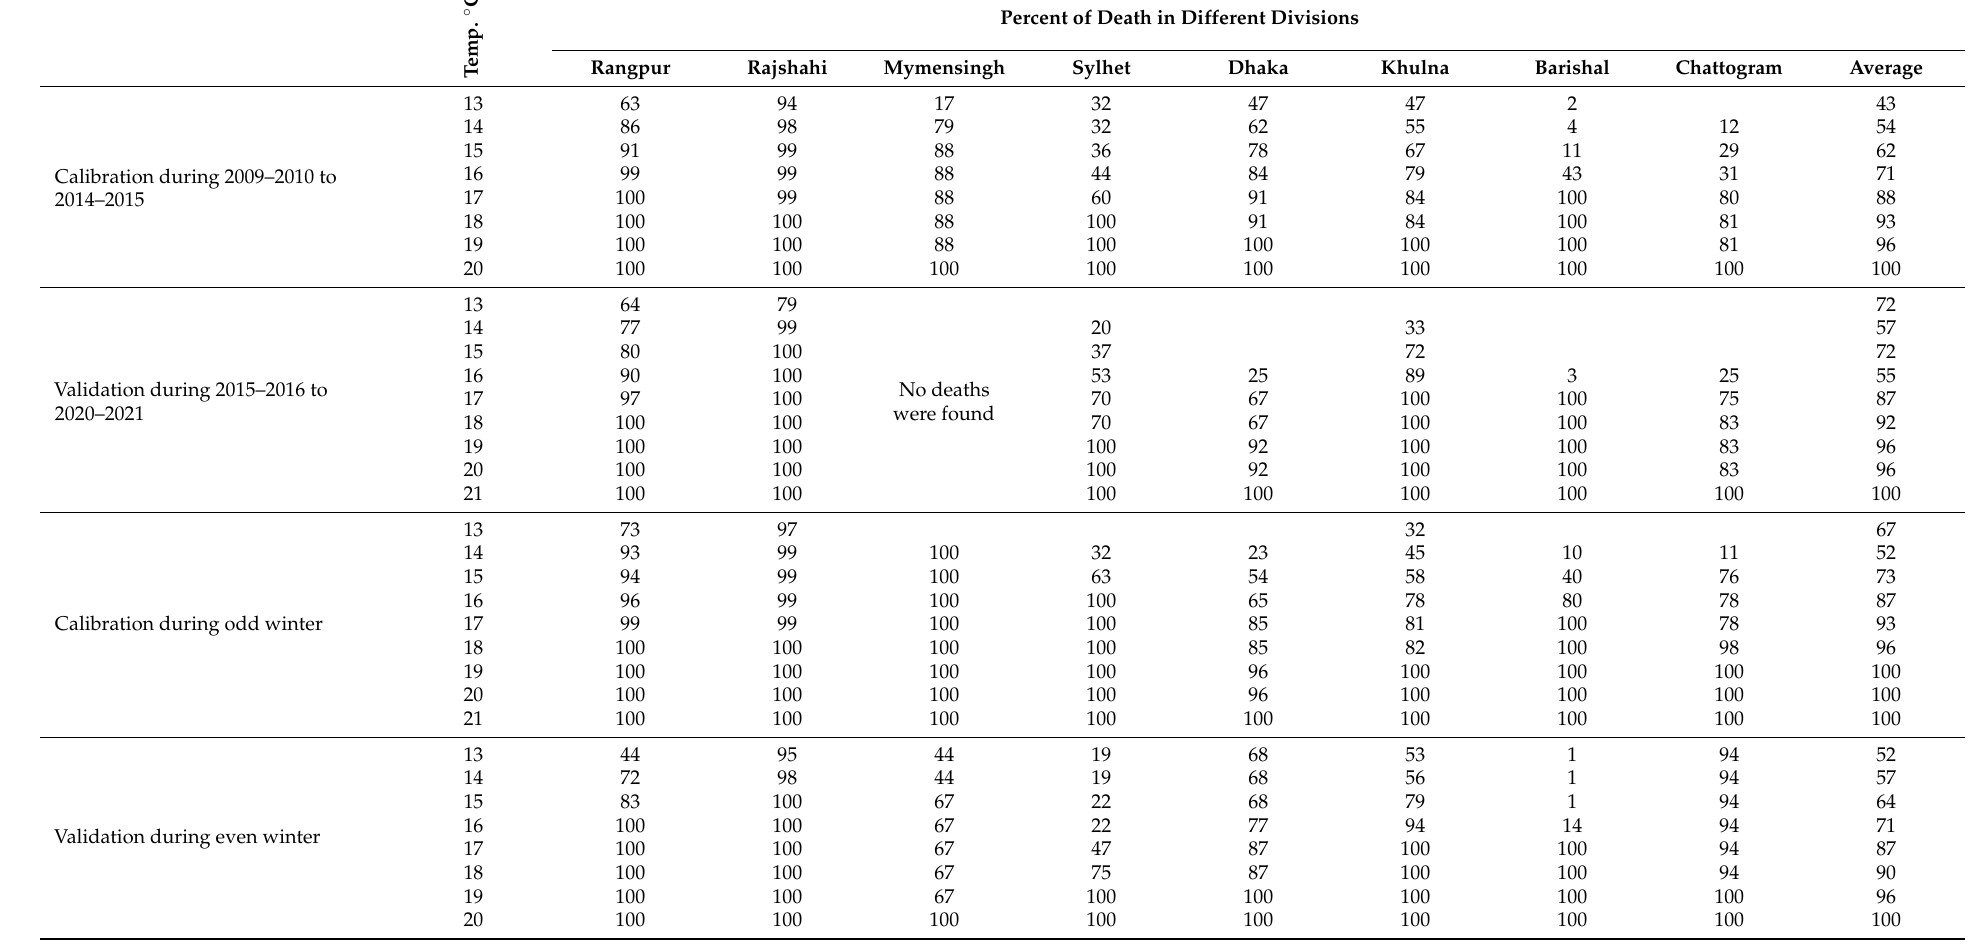
Table 2. Cold-related deaths in different divisions at different T avg for calibration and validation during the winters of 2009–2020,